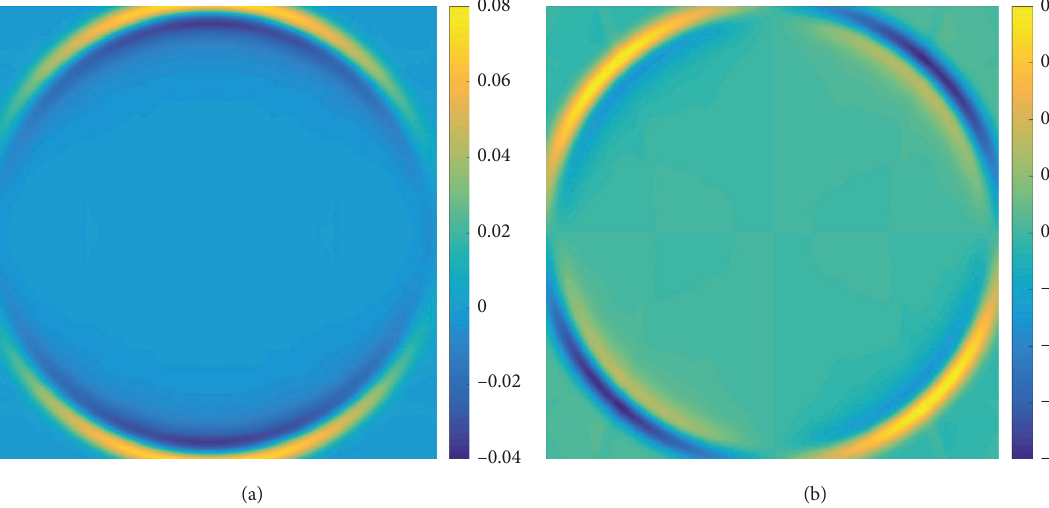
Figure 6: Velocity distribution in x and y directions at time � 1.5s. (a) x direction (b) y